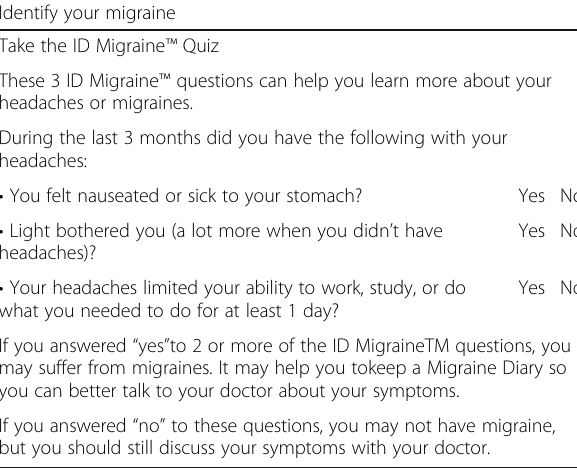
Table 6 The Migraine-ID ™ questionnaire Identify your migraine